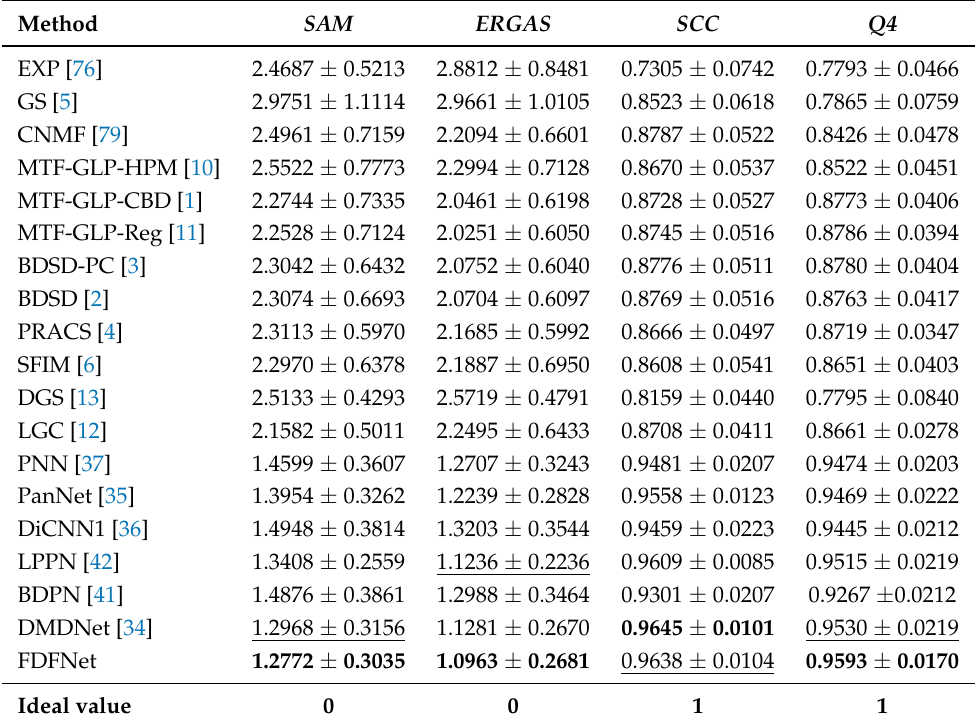
Figure 8. The visual comparisons of fusion results obtained by different methods on a reduced- resolution GF case (shown by bands: 1, 3, and 5). Table 4. Average quantitative with the related standard deviations (std) comparisons on 81 reduced- resolution GF2 examples. The best performance is shown in bold and second place is